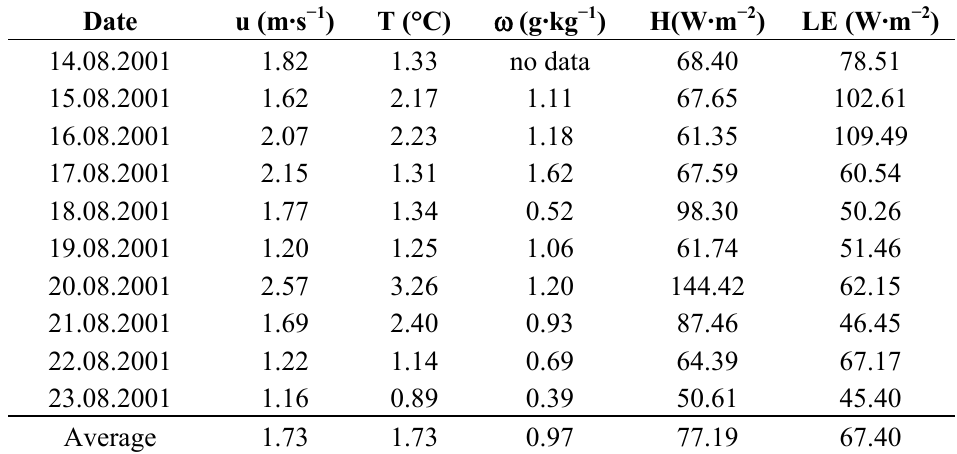
Table 4. RMSE per day estimated from modelled and measured half-hourly tower fluxes and meteorology using CORINE land cover data. Symbols are: u = wind speed, T = air temperature, ω = air humidity mixing ratio, H = sensible heat flux and LE = latent heat